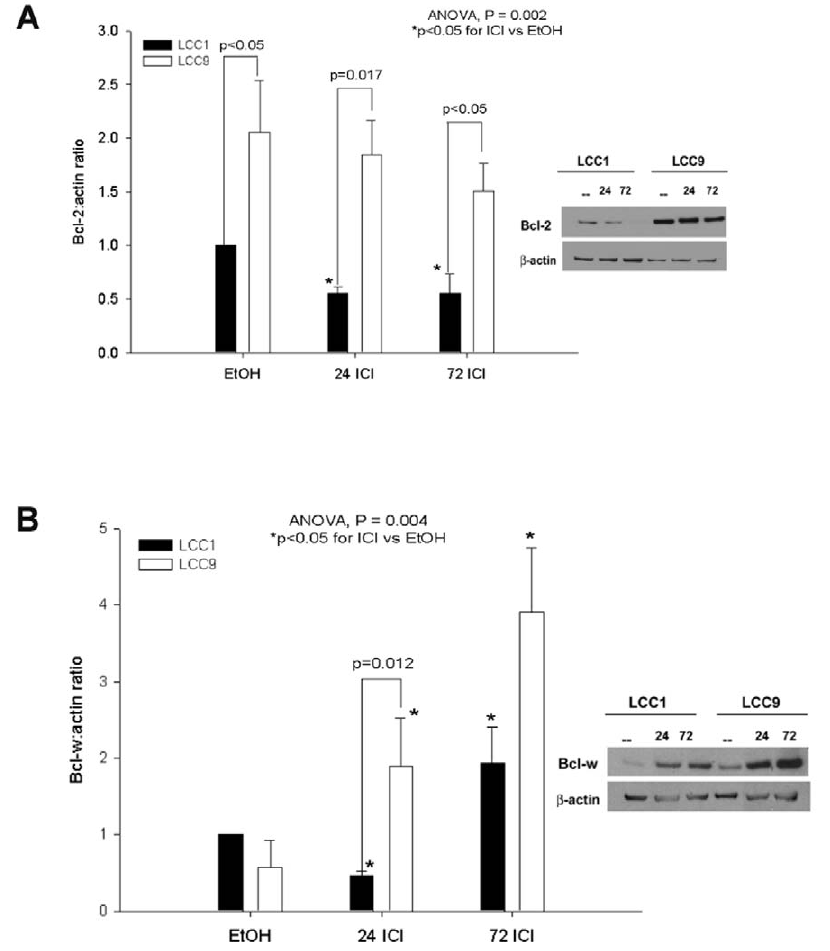
Figure 1. Increased expression of BCL-W and BCL2 in MCF-7/LCC9 cells. Whole cell lysates were subjected to Western blot analysis with a specific BCL2 or BCL-W antibody. ( A ) Bars represent the mean 6 SE of the relative BCL2:actin ratio (normalized to control cells) for three independent experiments. Inset , a representative blot . ( B ) Bars represent the mean 6 SE of the relative BCL-W:actin ratio (normalized to control cells) for three independent experiments. Inset, a representative blot .